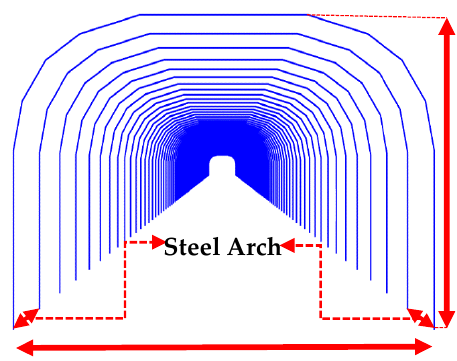
Figure 3. Model Dimensions.